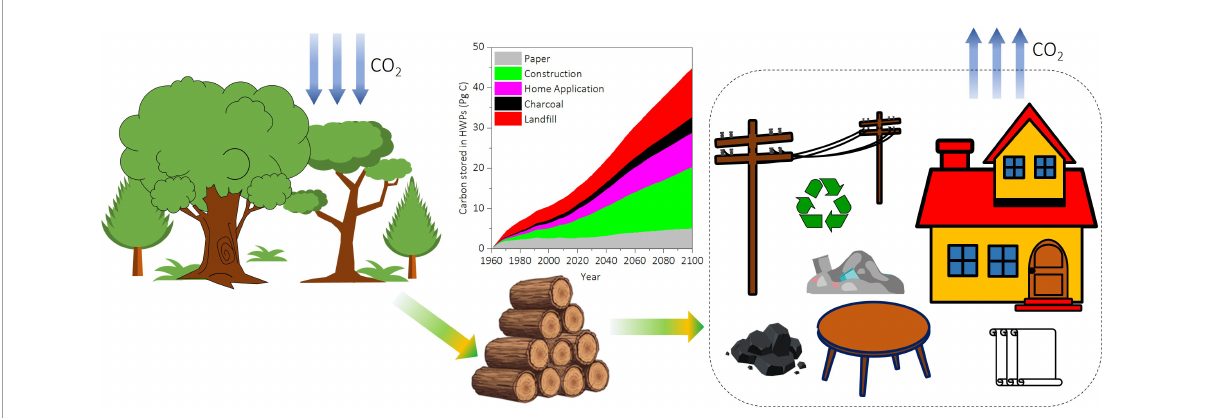
FIGURE1 The carbon flux from forest sectors to the harvested wood products (HWPs) carbon pool and the predicted carbon accumulated in the global HWPs carbon pool from 1961 to 2100 (The carbon accumulated in HWPs carbon pool from 1961 to 2100 was estimated with the data and accounting framework provided by Daigneault et al. (2022) and Li et al. (2022),